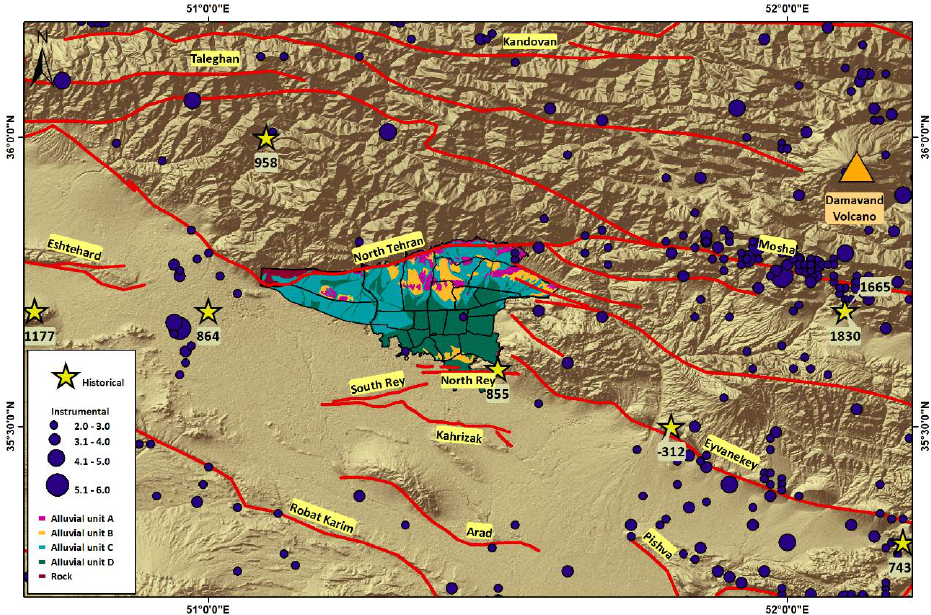
Figure 1. Active faults, historical and instrumental seismicity and alluvial deposits in and around